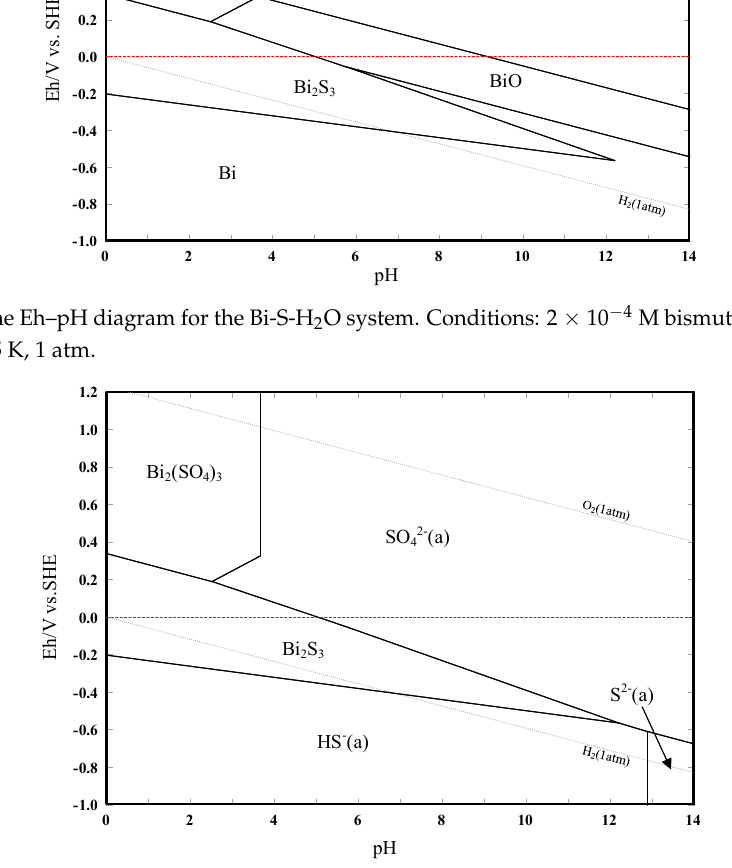
Figure 12. The Eh–pH diagram for the S-Bi-H 2 O system. Conditions: 3 × 10 − 4 M sulfur, 2 × 10 − 4 M Figure 12. The Eh–pH diagram for the S ‐ Bi ‐ H 2 O system. Conditions: 3 × 10 − 4 M sulfur, 2 × 10 − 4 M bismuth, 298.15 K, 1 Figure 12. The Eh–pH diagram for the S ‐ Bi ‐ H 2 O system. Conditions: 3 × 10 − 4 M sulfur, 2 × 10 − 4 M bismuth, 298.15 K, 1 atm. Figure 12. The Eh–pH diagram for the S ‐ Bi ‐ H 2 O system. Conditions: 3 × 10 − 4 M sulfur, 2 × 10 − 4 M bismuth, 298.15 K, 1 atm. bismuth, 298.15 K, 1 atm.